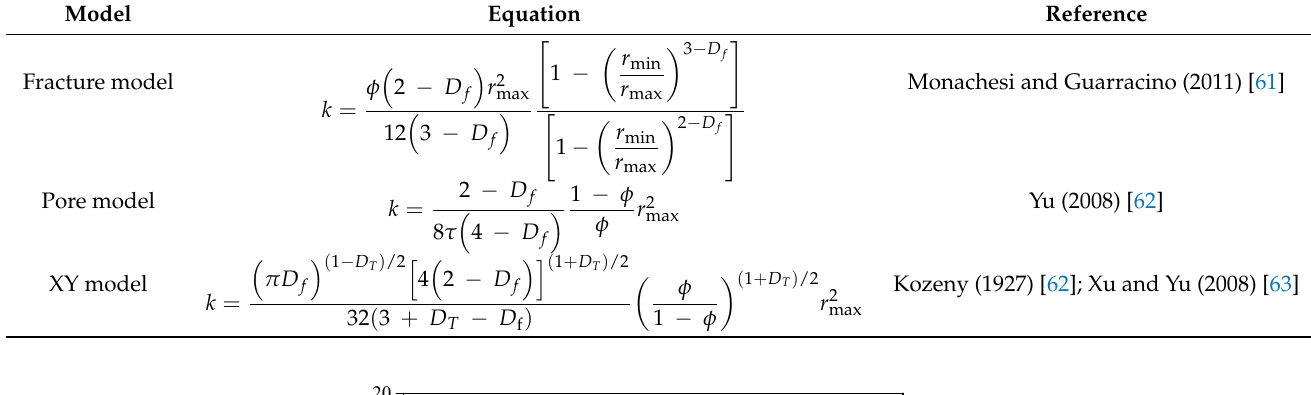
Table 2. Some of the models for porous media permeability estimation.